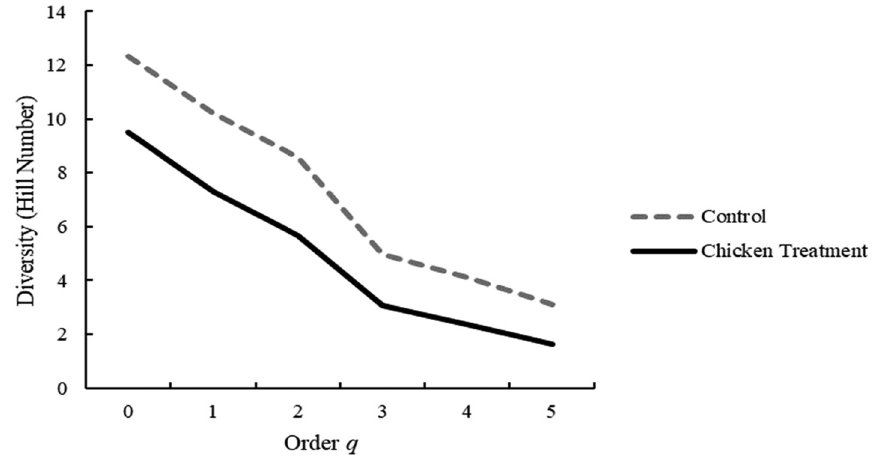
Figure 5: Diversity pro fi les ( Hill numbers ) of the chicken treatment and the control, after grazing, at the orchard.